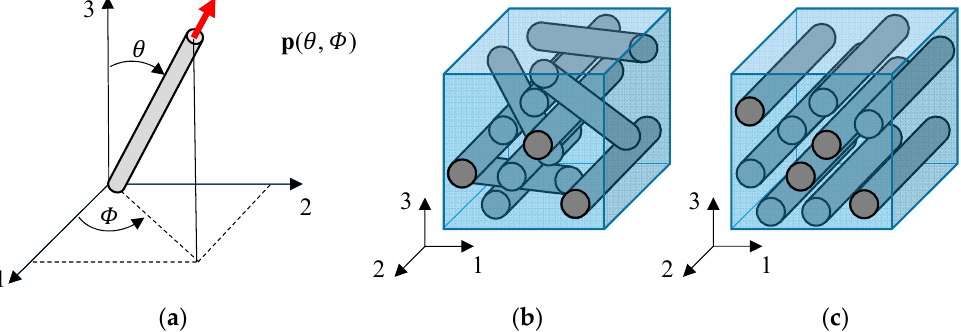
Figure 1. Representation of the orientation of a single rigid fiber by the vector 𝒑 ( 𝛷 , 𝜃 ) ( a ) adapted after [44]; orientation of a fiber population within a volume: randomly oriented fibers ( b ) and aligned fibers ( c ), adapted after [36].